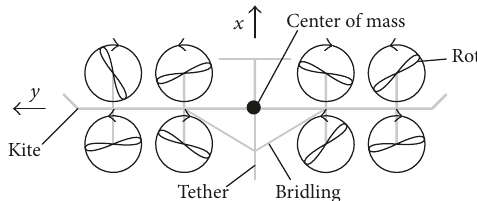
Figure 7: Example of meaningful rotor placement with eight rotors (similar to Makani’s design [6, 7]).